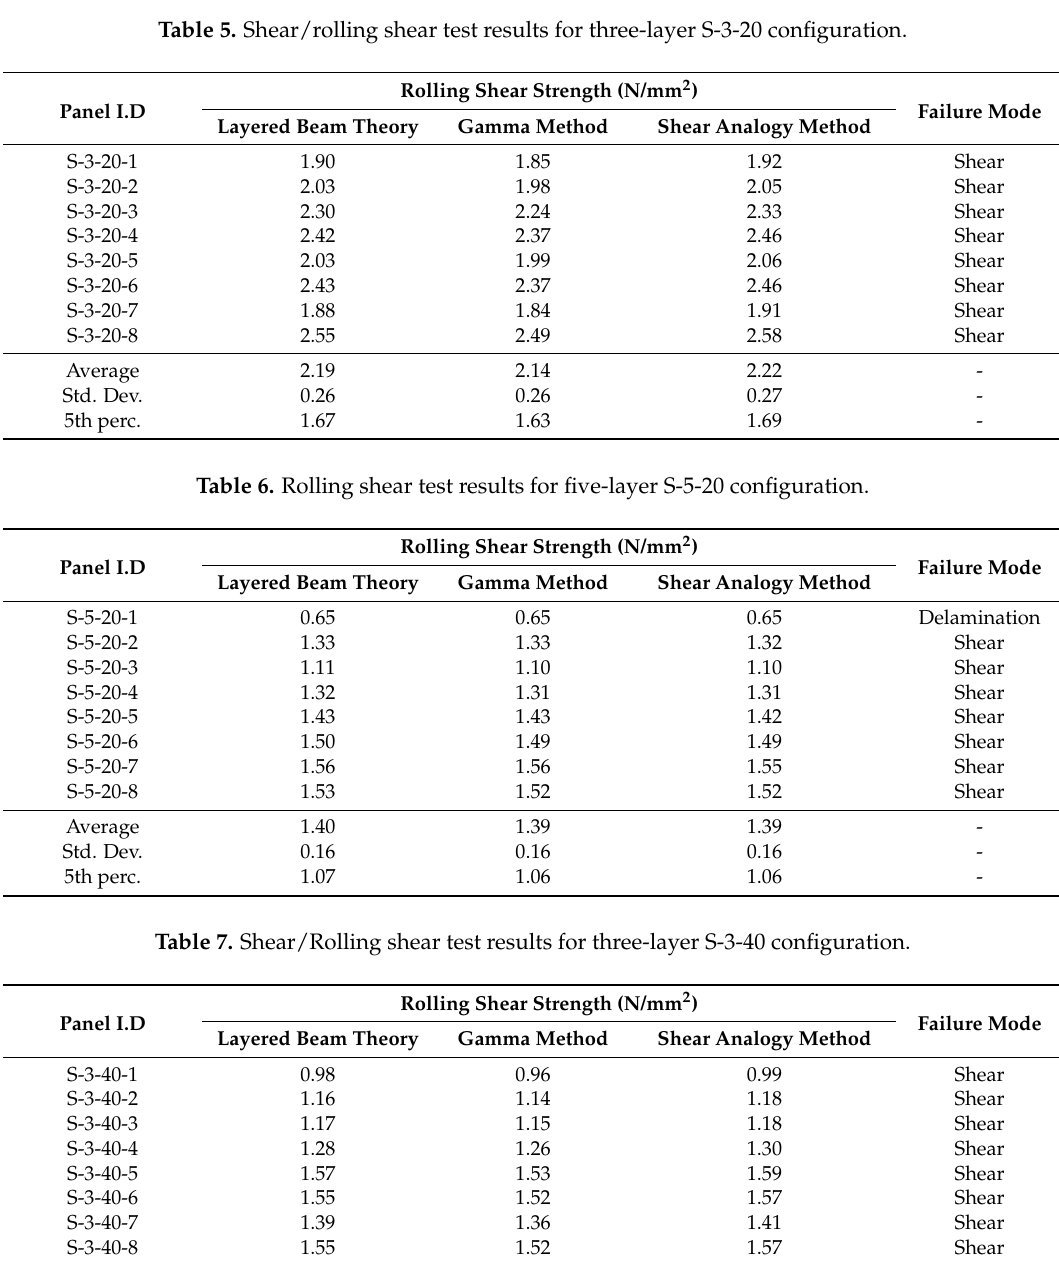
Table 5. Shear/rolling shear test results for three-layer S-3-20 configuration.